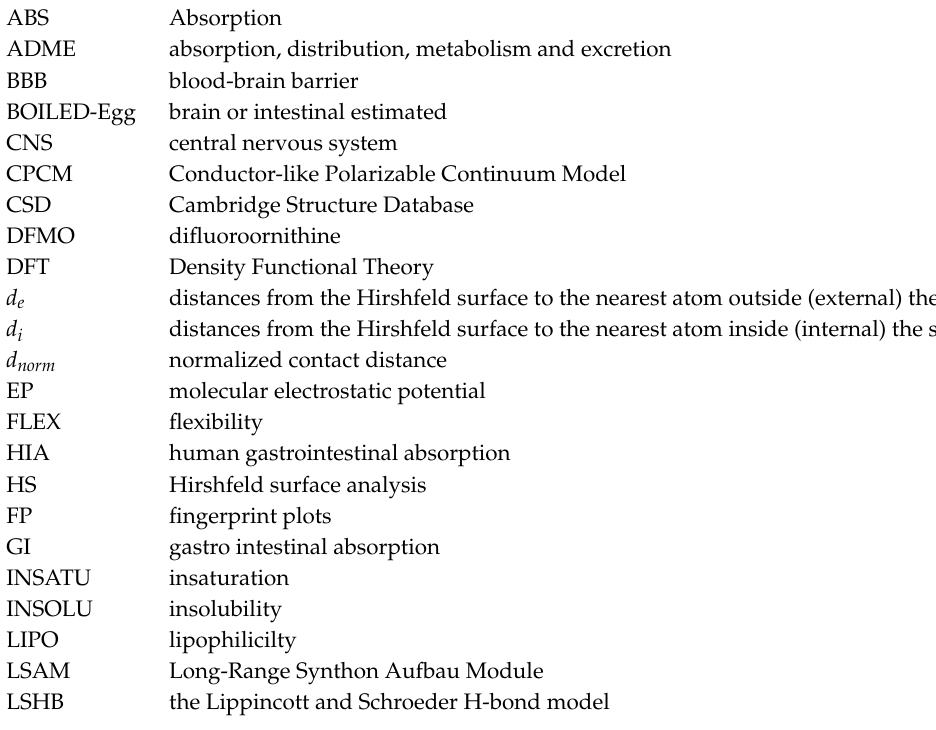
Table 1. Table 1. Table 1. Crystallographic data and structure refinement parameters for 1 . Table 1. Crystallographic data and structure refinement parameters for 1 .